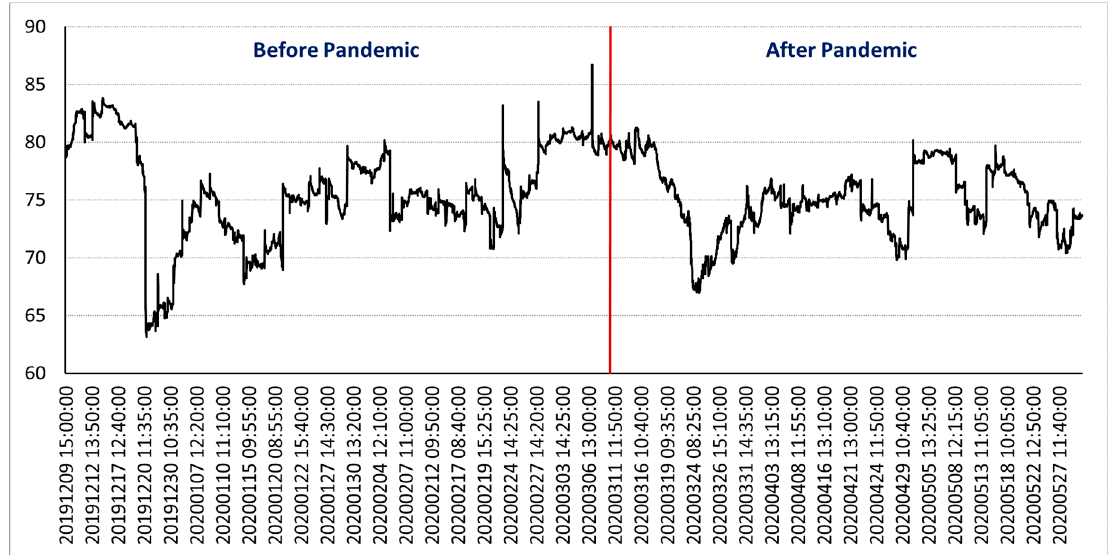
Figure 1. Total Intraday volatility spillovers for all 12 European Stock Markets during COVID-19. (11 March 2020).